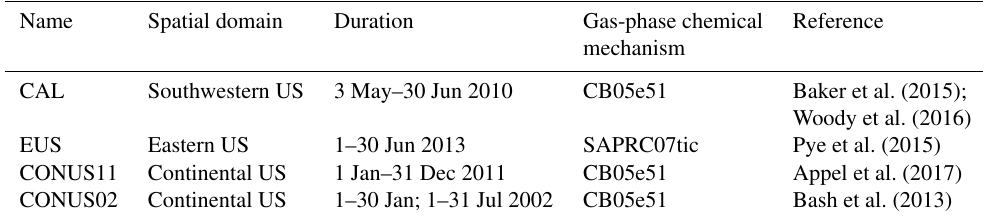
Table 3. CMAQ model scenarios used for this